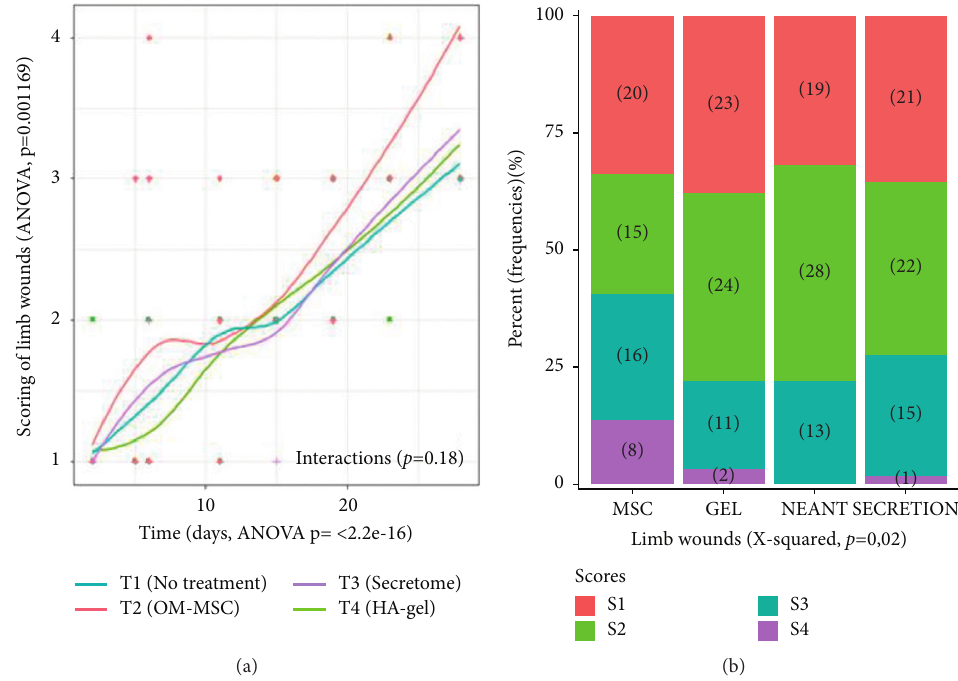
Figure 6: Limb wound noninvasive assessment. (a) A Fisher two-way ANOVA revealed a significant effect of treatment on FL wounds ( p � 0 . 0012). Linear model analysis reveals a significant difference between T2 (OM-MSC) and T1 (control) ( p � 0 . 001289). (b) OM-MSC shows an increase in the frequency of scores 3 and 4, respectively, related to an increase of contraction and contract on epithelialization of the FL